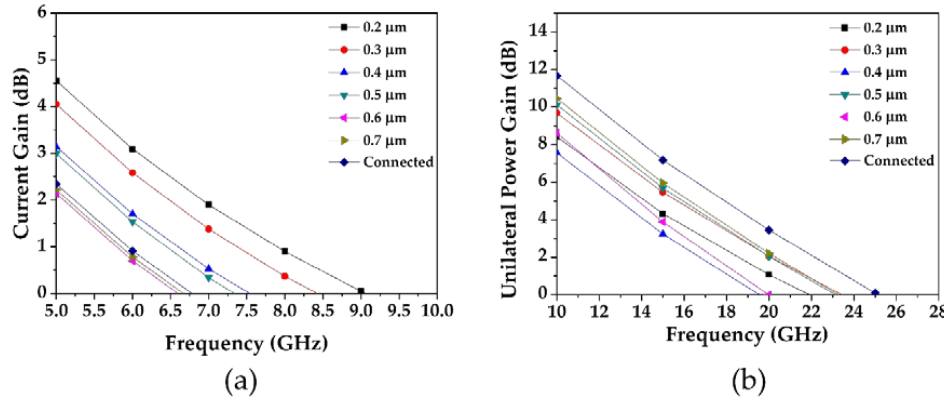
Figure 9. Gains as a function of frequency for various IFP lengths: ( a ) cut-off frequency at 0 dB; ( b ) maximum frequency at 0 dB.